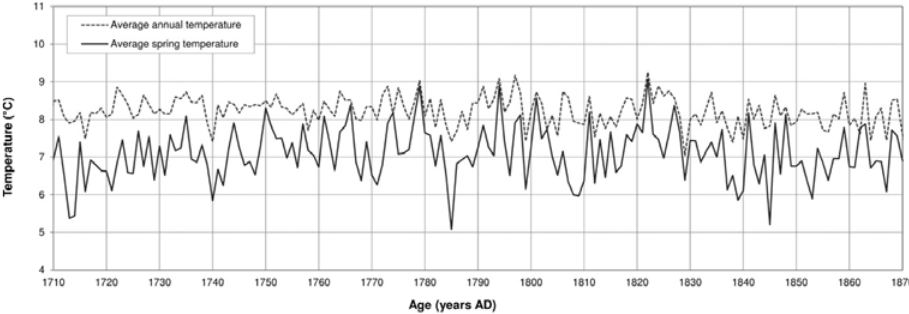
Figure 4. Average annual temperature versus average spring temperature in the period analysed (from Lutherbacher et al. 2004).